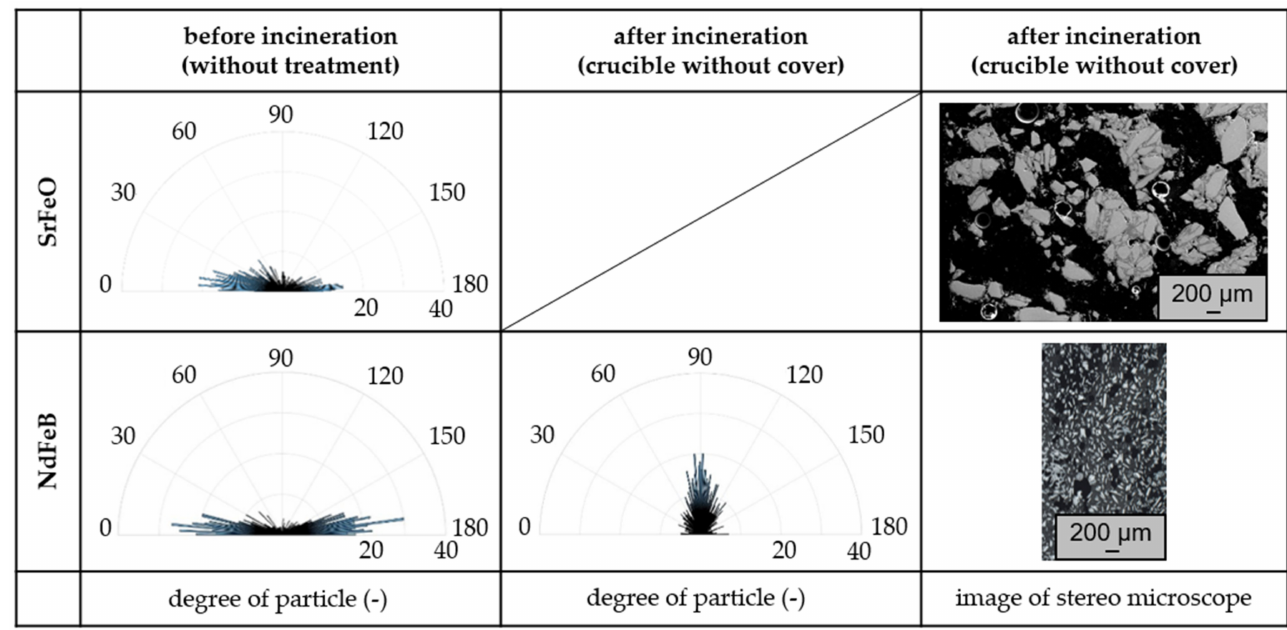
Figure 9. Filler orientation of samples with 50 vol.-% filler content before and after incineration with oxygen